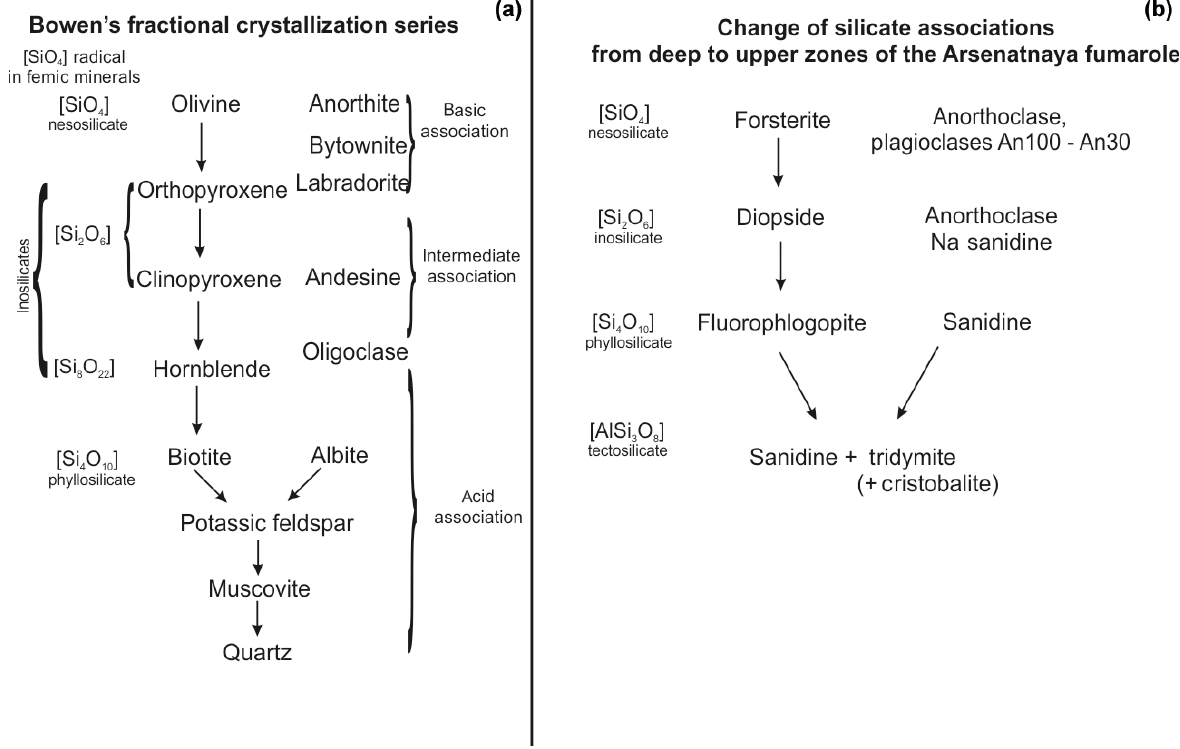
Figure 10. Comparison of Bowen’s crystallization series ( a ; composed using the diagram by Bowen, 1922) and the distribution of sili- cate minerals along the vertical section (arrows mark the evolution of mineral composition from deep to upper zones) of the Arsenatnaya fumarole (b)